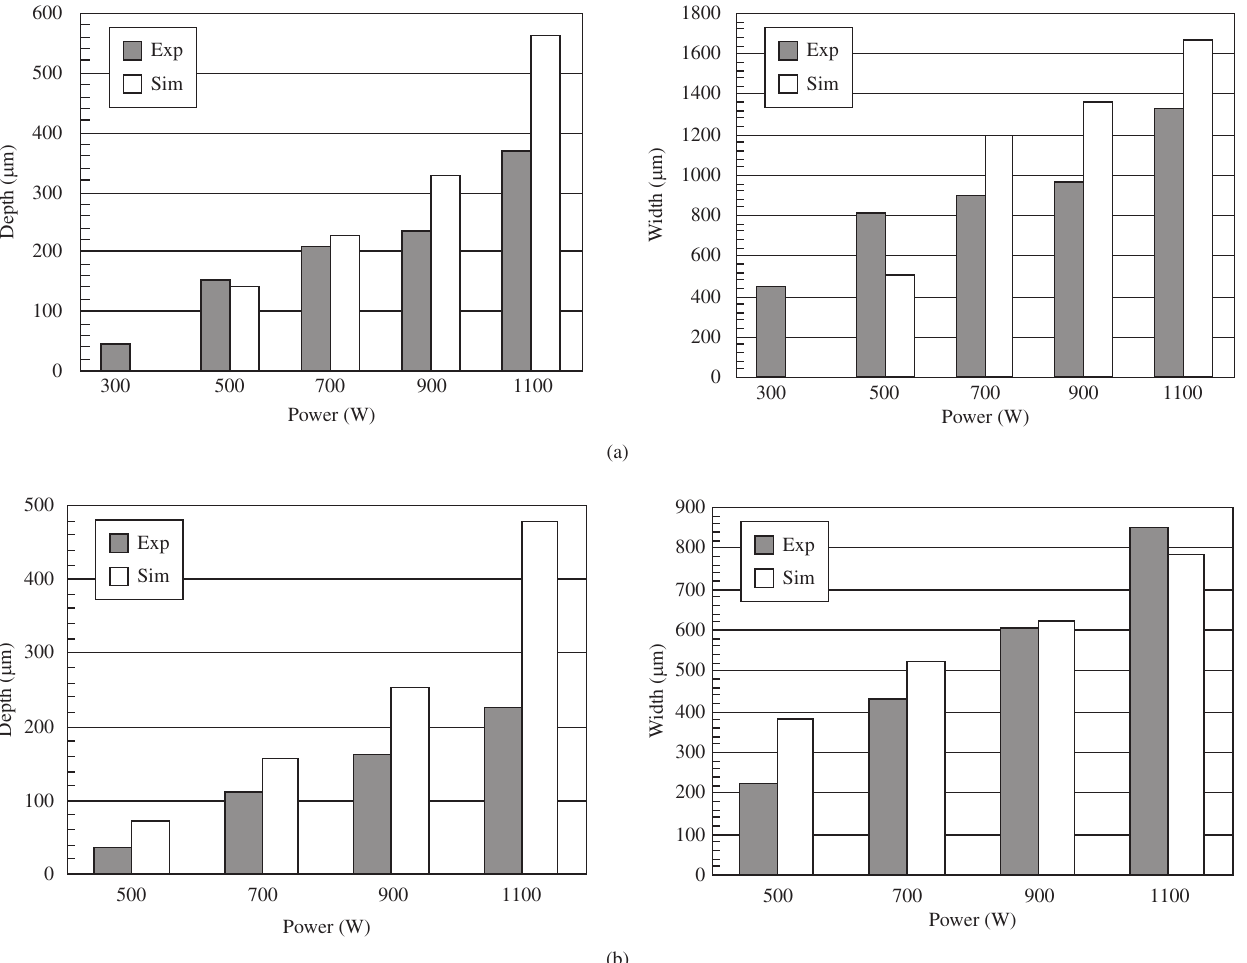
Figure 5. Comparison between experimental and simulated dimensions of the laser tracks for different power levels. a) Partially transformed region (PTR); and b) martensitic region (MR). MR, and the other composed of proeutectoid ferrite, unchanged pearlite and martensite, called here the Partially Transformed Region or PTR. Except at 300 W where the material remained practically unchanged, the rippled shape of the upper surface, indicates that part of the martensite came from melting followed by rapid